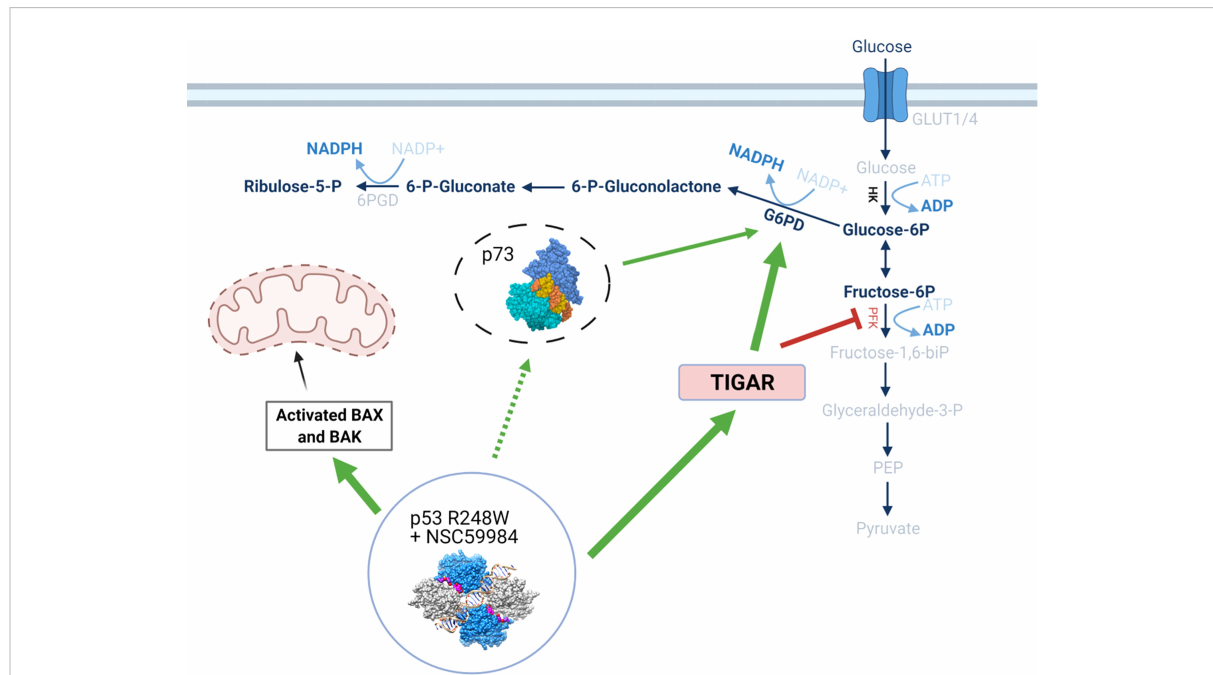
FIGURE 9 Schematic detailing the effects of p53 stabilization on metabolic pathways. The stabilization of the p53 structure upon treatment with NSC59984 initiates a cascade of effects through both transcriptional- and non-transcriptional regulation. Via transcriptional regulation, stabilized p53 increases expression of TIGAR which causes a subsequent reduction of PFK and blocks glycolysis. A concurrent increase in G6PD potentially mediated by p73 having been released from an inhibitory complex with mutant p53 (dashed line) allows the processing of glucose to fl ow through the PPP via increased HK and Glucose-6P. This reduces cellular energetics and subsequently cellular proliferation. Simultaneously, a transcriptional increase in Bax allows increased cytochrome C release from the mitochondria with ensuing intrinsic apoptosis. Labels in BOLD indicate measured increases following treatment with NSC59984. * = 0.05, ** = 0.005, *** = 0.0005, **** =